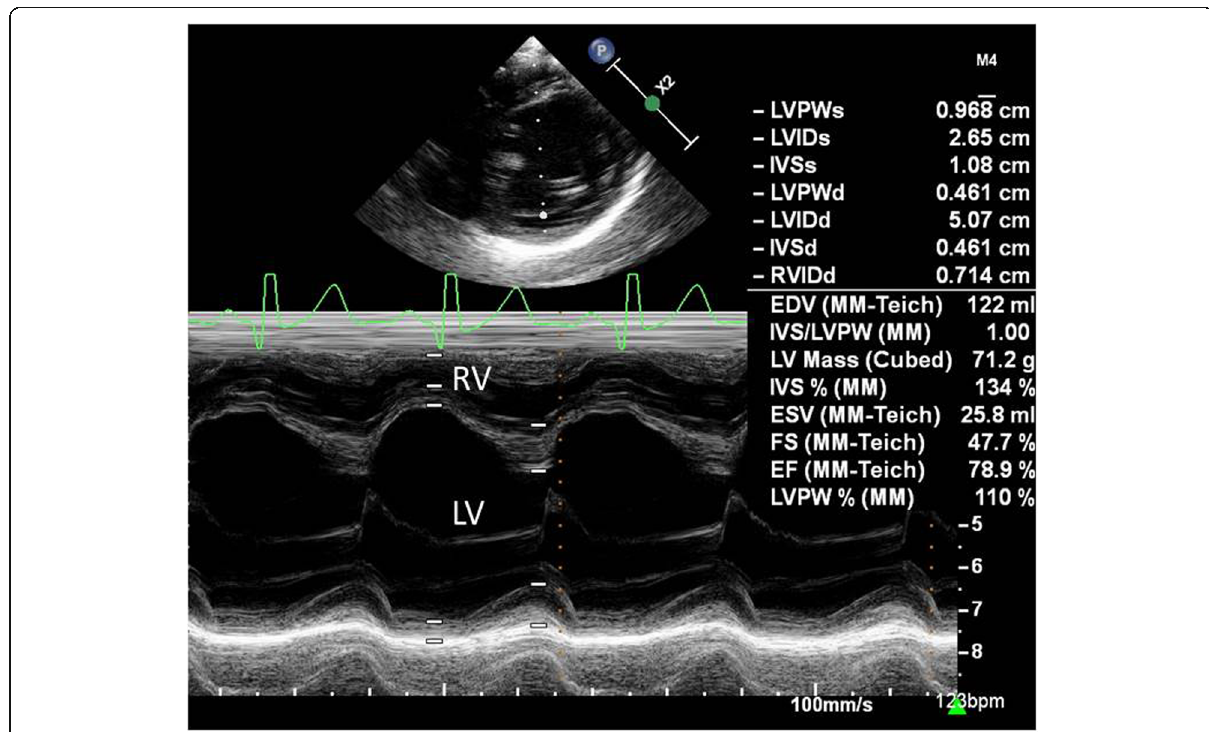
Fig. 2 M mode of right and left ventricles (age: 9.5 months). Left ventricle is extremely enlarged (50.7 mm), with preserved ejection fraction (78.9%). RV: right ventricle; LV: left